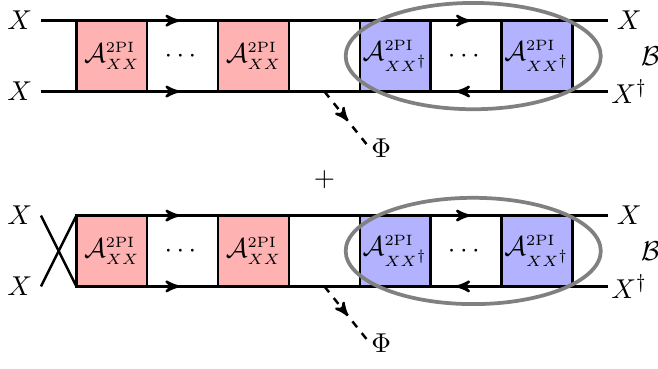
Figure 3 . The capture into bound states via emission of a charged scalar (BSF B ( XX y ) + (cid:8). There is also the conjugate process, X y + X y ! B ( XX y ) + (cid:8) y . The arrows denote the (cid:13)ow of the U(1) D charge. Note that in this case, the diagrams in which the incoming XX particles emit o(cid:11)-shell V and (cid:8) that fuse to produce the (cid:12)nal state (cid:8) are of higher order, and we do not consider them